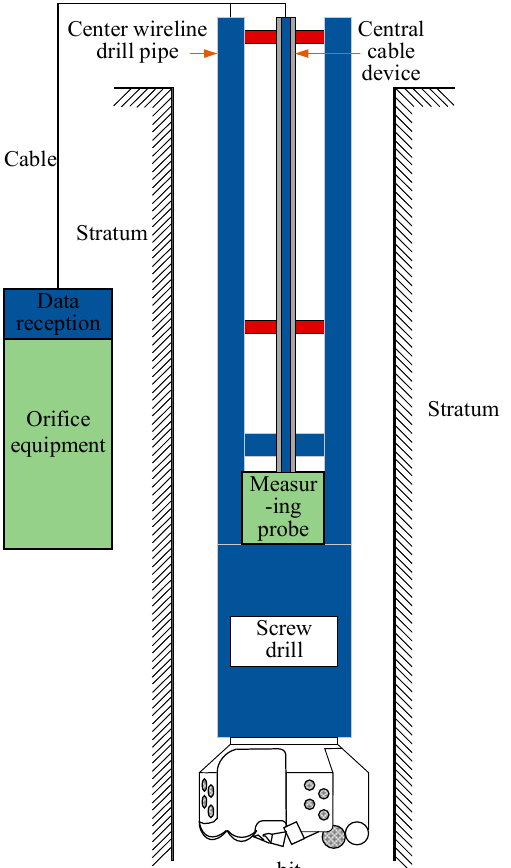
Figure 4. Schematic diagram of underground wired signal transmission in coal mine.